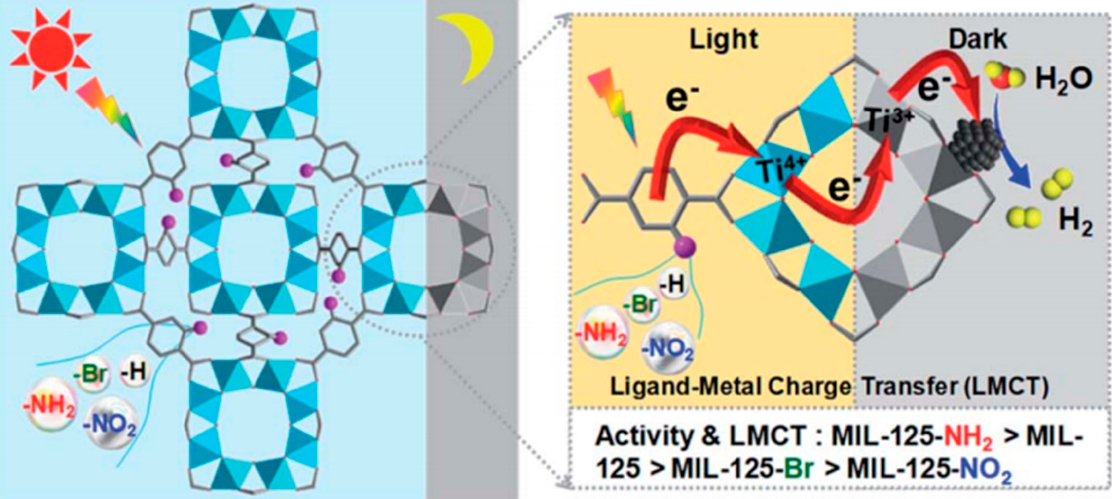
Figure 2. The illustration of the dark photocatalysis based on the MIL-125 and MIL-125-X (X = NH 2 , NO 2 and Br). Reproduced with permission from Ref. [62].